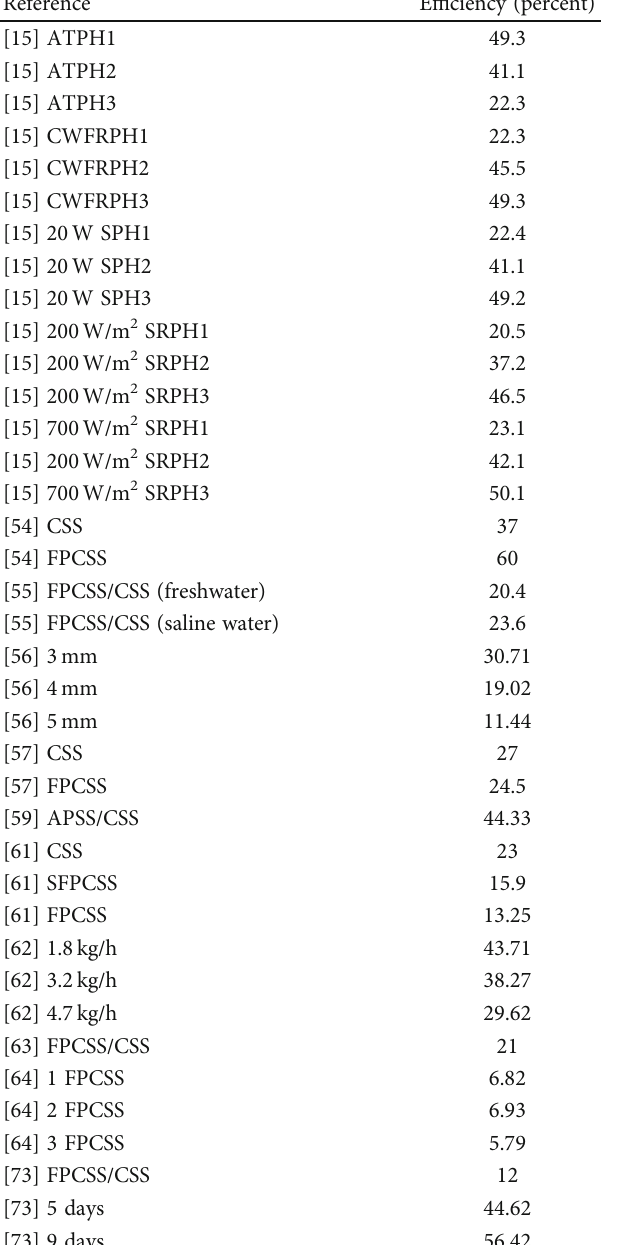
Table 1: Solar still e ffi ciency of studied references.